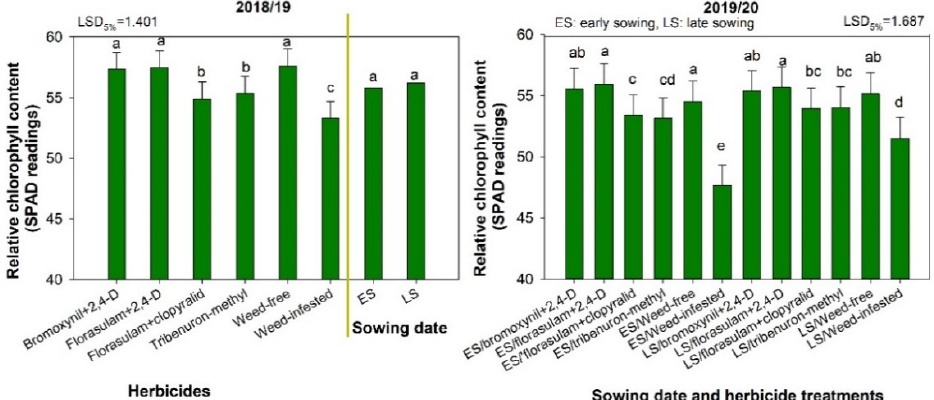
Figure 2. Relative chlorophyll content (SPAD readings) as affected by the sowing date (early and late sowing) and the herbicide treatments (bromoxynil + 2.4-D, florasulam + 2.4-D, florasulam + clopyralid, tribenuron-methyl, weed-free, and weed-infested). Means followed by the same letters do not significantly differ with Fisher’s least significant difference (LSD) test. Error bars indicate the LSD values. Table 5. Durum wheat plant’s height (cm) as affected by the sowing date (early and late sowing) and the herbicide treatments (bromoxynil + 2.4-D, florasulam + 2.4-D, florasulam + clopyralid, tribenuron-methyl, weed-free, and